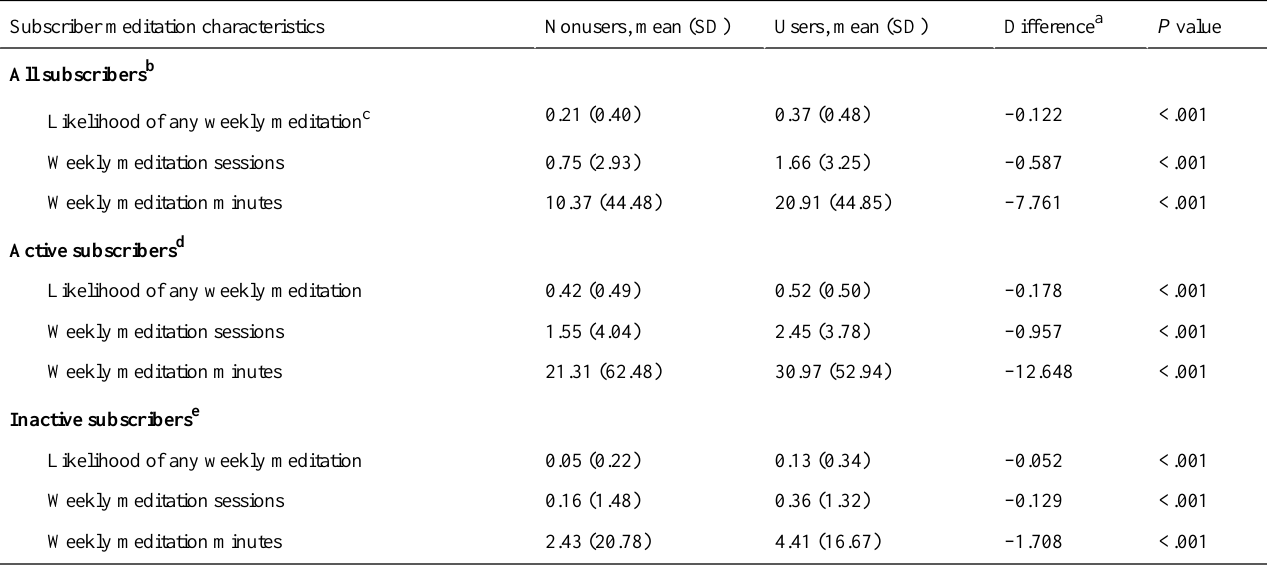
Table 3. Meditation behavior of users of mood check-ins vs nonusers of mood check-ins.